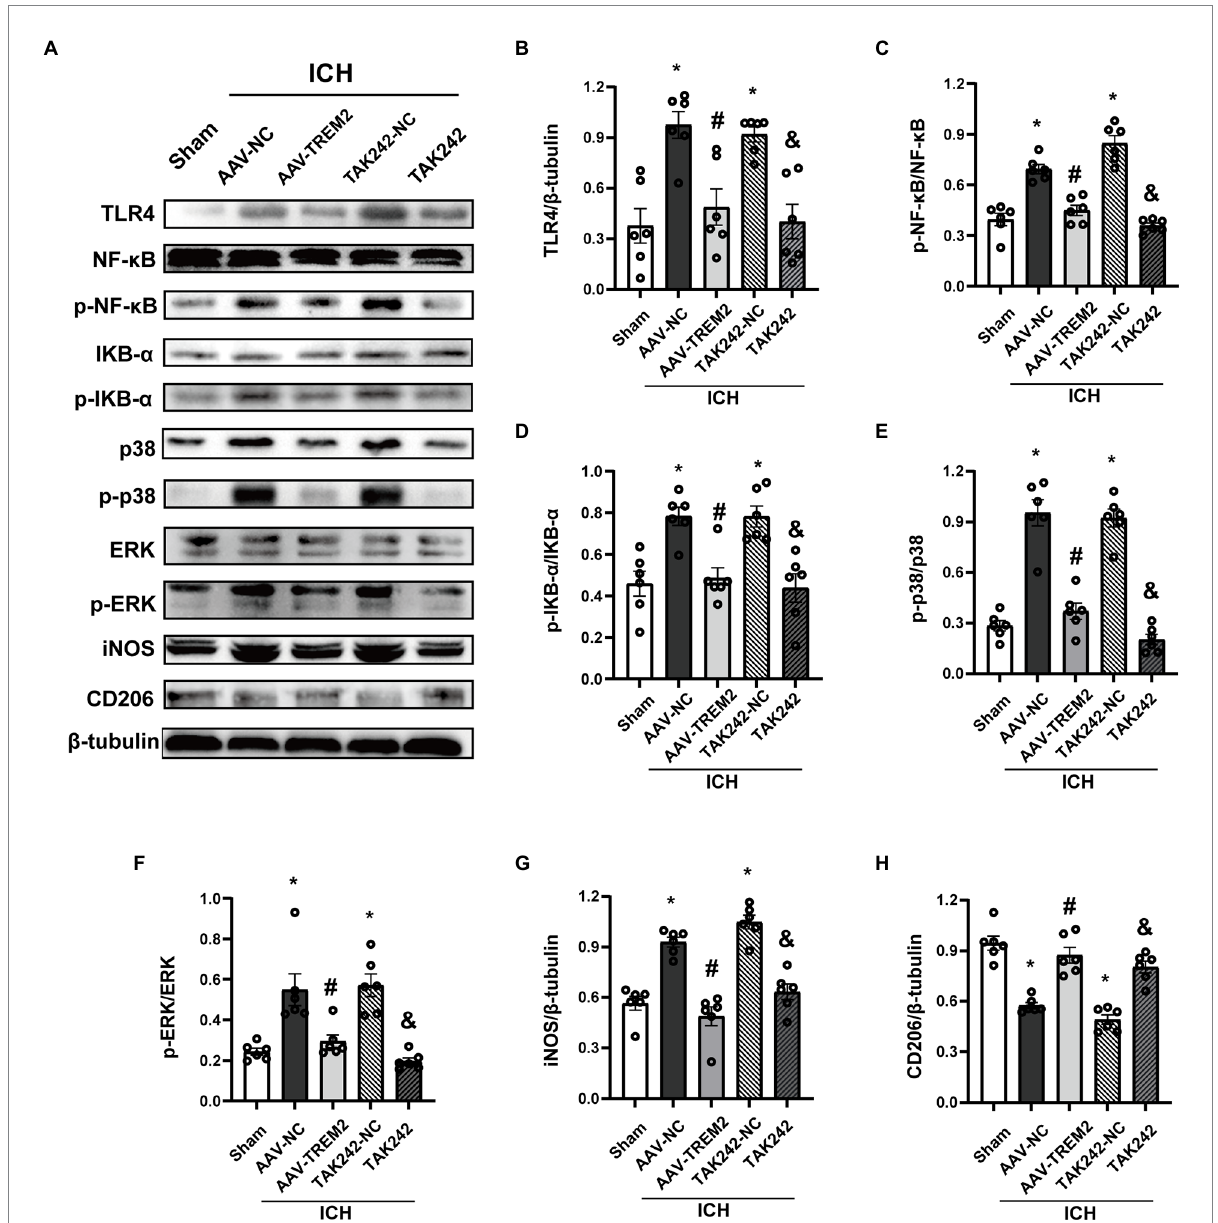
FIGURE 3 TREM2 overexpression inhibited TLR4-NF- κ B and TLR4-MAPK pathways. (A) Representative western blot bands. (B–H) Quantitative analyses of TLR4, phosphorylated NF- κ B, IKB- α , p38 and ERK, iNOS and CD206 in the ipsilateral hemisphere at 24 h after intracerebral hemorrhage. * p < 0.05, vs. the sham group, # p < 0.05, vs. the AAV-NC + ICH group, & p < 0.05, vs. the TAK242-NC + ICH group. ICH: intracerebral hemorrhage, AAV, Adeno- associated virus; LV, lentivirus; NC, negative controls. The data were represented as mean ± SEM. n = 6 per